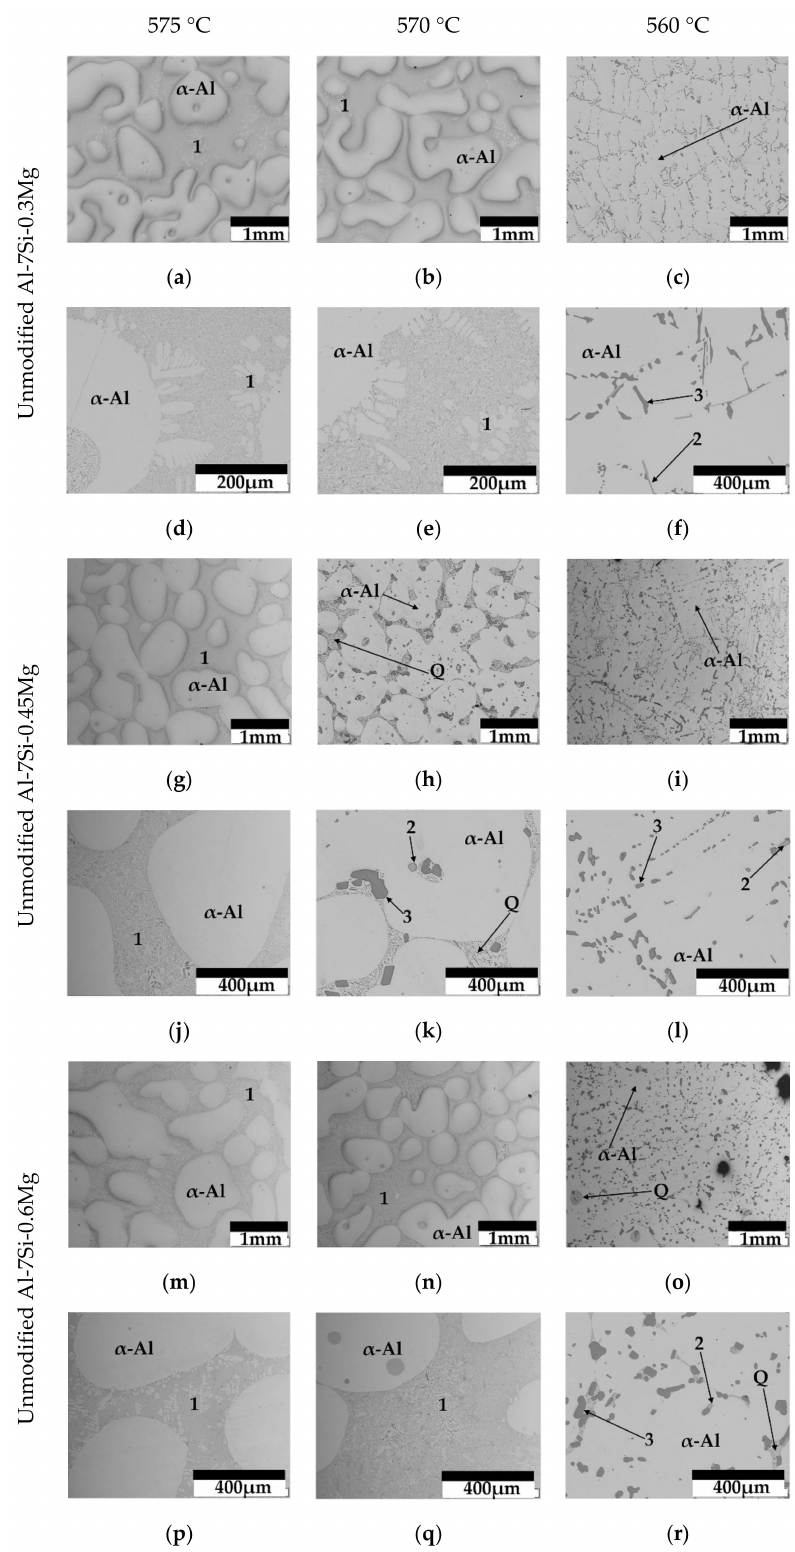
Figure 4. Micrographs of the unmodified Al-7Si-Mg alloys held isothermally at 560 ◦ C, 570 ◦ C and 575 ◦ C during 120 h: ( a–f ) Al-7Si-0.3Mg, ( g–l ) Al-7Si-0.45Mg and ( m–r ) Al-7Si-0.6Mg alloys. Region 1: primary α -Al dendrites + eutectic. Region 2: iron-rich intermetallic. Region 3: eutectic silicon. Q: quenched